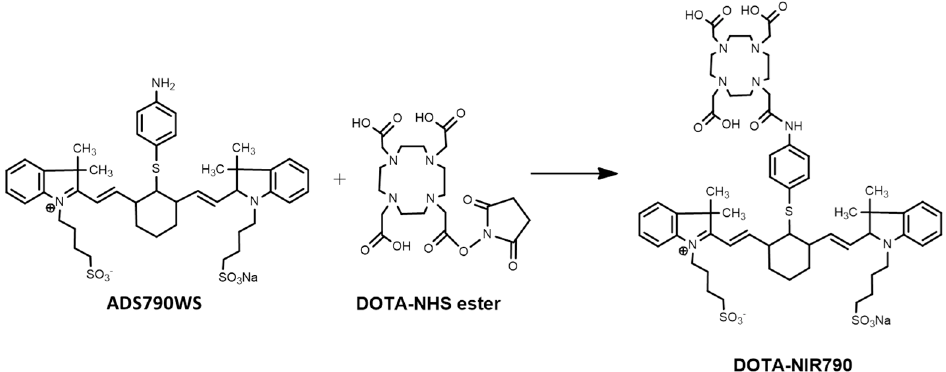
Figure 1. Synthesis of DOTA-NIR790.